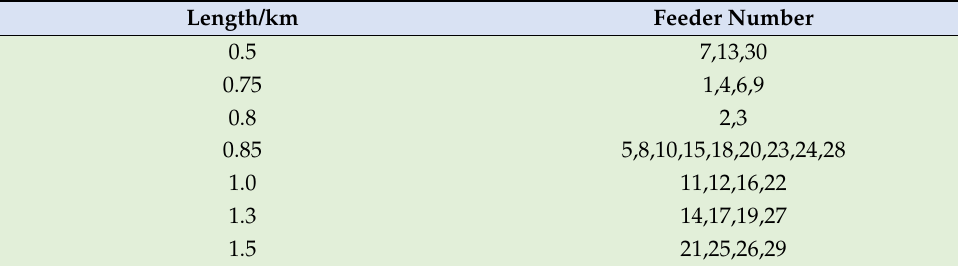
Table 2. Length of feeder section.